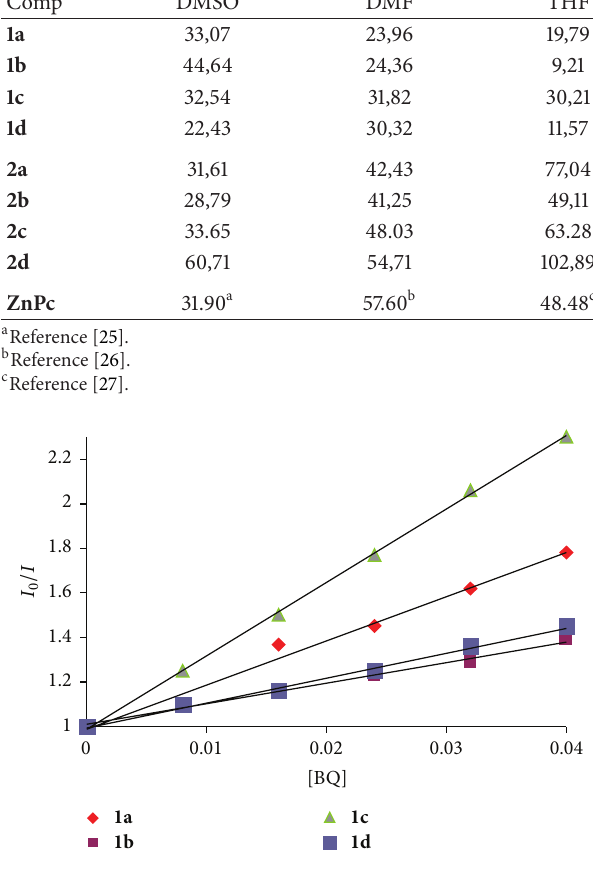
Figure 7: Stern-Volmer plots for benzoquinone (BQ) quenching of substituted zinc phthalocyanine complexes 1a–1d in THF. [MPc] ∼ 1.00 × 10 −5 moldm −3 in DMSO, DMF, and THF. [BQ] = 0, 0.008, 0.016, 0.024, 0.032, and 0.040 mol dm −3 in all solvents